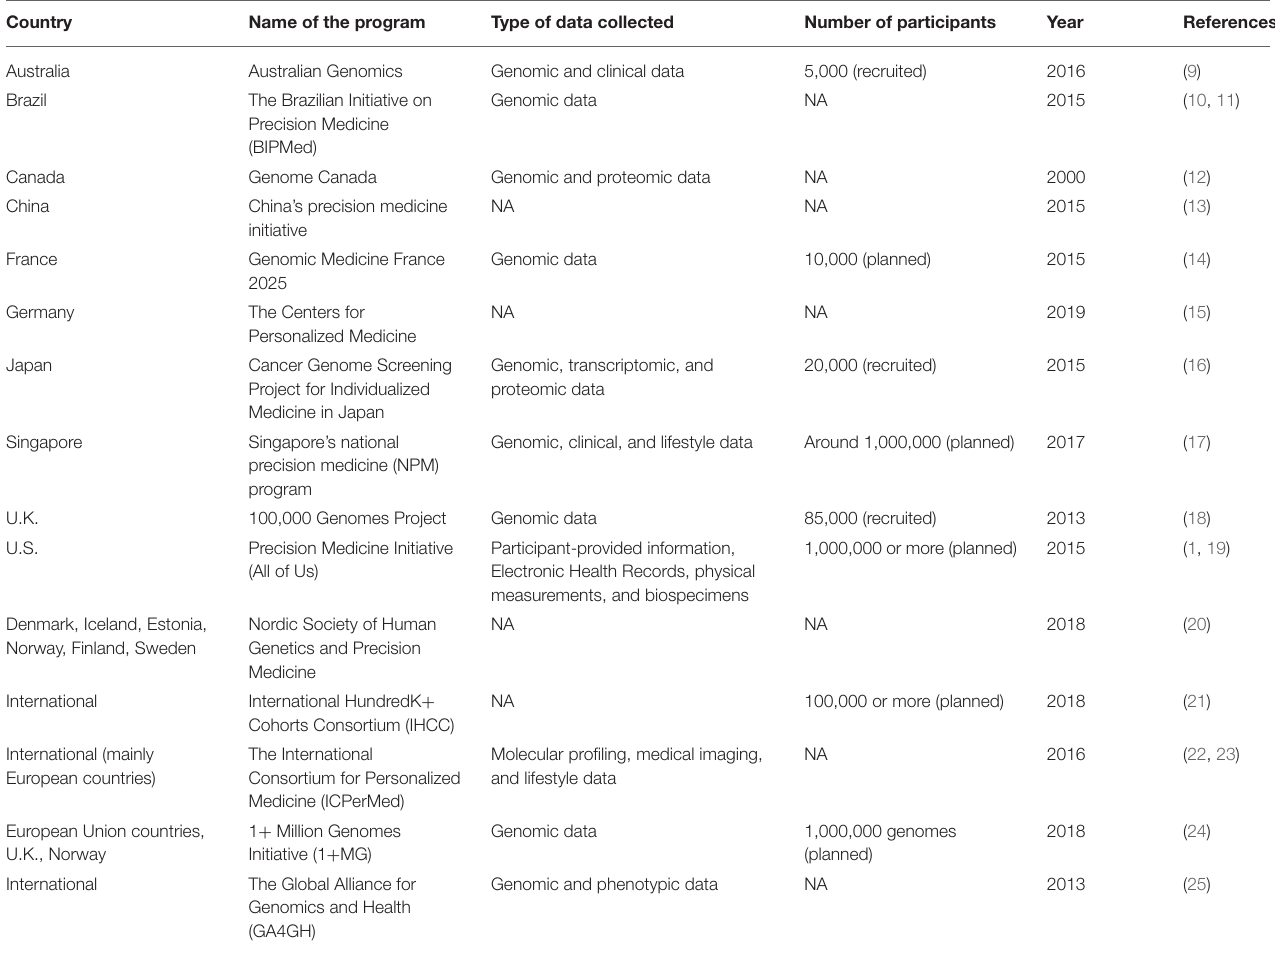
TABLE 1 | A non-exhaustive list of PM programs in different countries and regional or international PM programs.